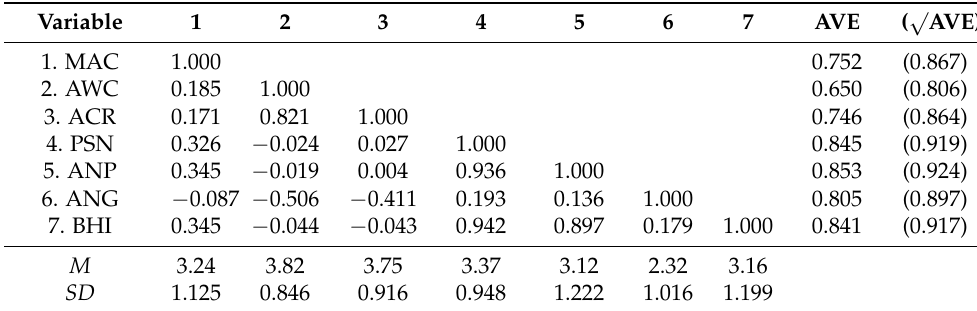
Table 4. The results of the CFA model and factor correlations ( n =